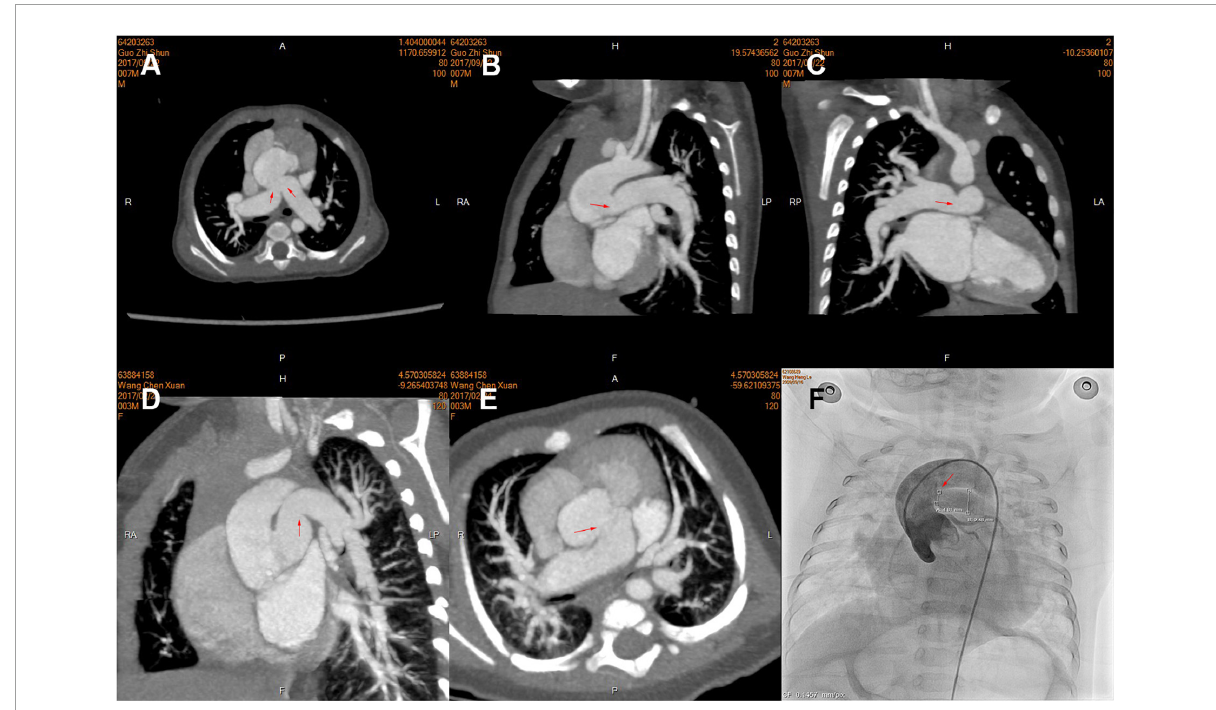
FIGURE3 Pre-operative computed tomography (CT) angiography and cardiac catheterization showing branch pulmonary artery (PA) morphology of the different types of truncus arteriosus (TA), including the proximal and distal in three patients. (A–C) Type A2; (D,E) Type A1; (F) Type A3. The opening of branch PAs is labeled by red